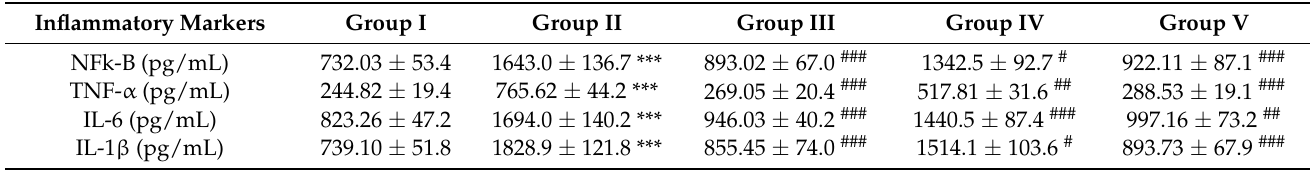
(Table 3). Zingerone (25 mg/kg b.w.) in group IV lowered increased levels of inflammatory